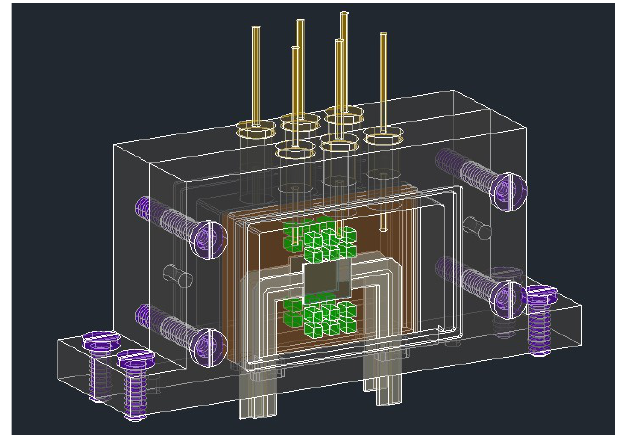
FIGURE 9. An x-ray view of the amplification module.